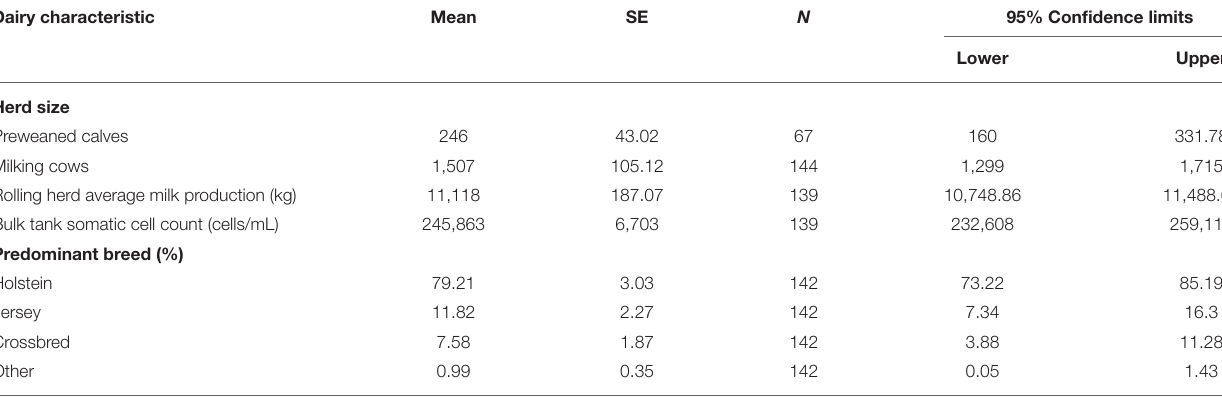
TABLE 1 | Summary dairy characteristics.